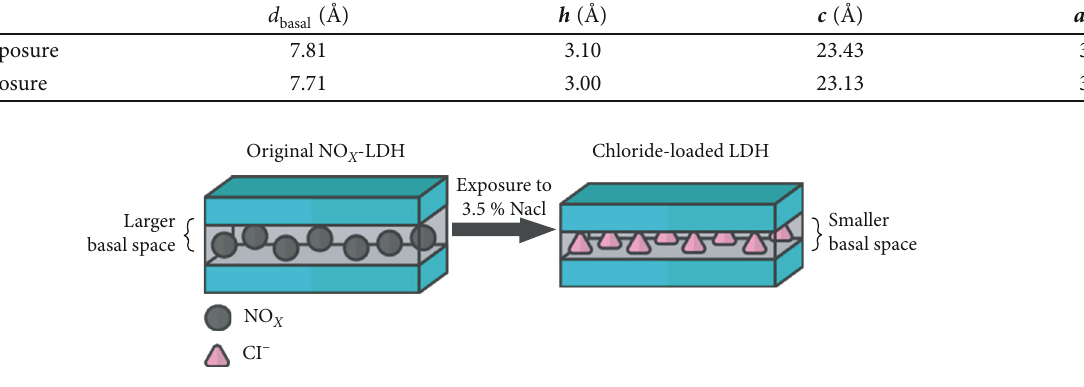
Figure 6: Schematic drawing of the ion-exchange process of pristine NO